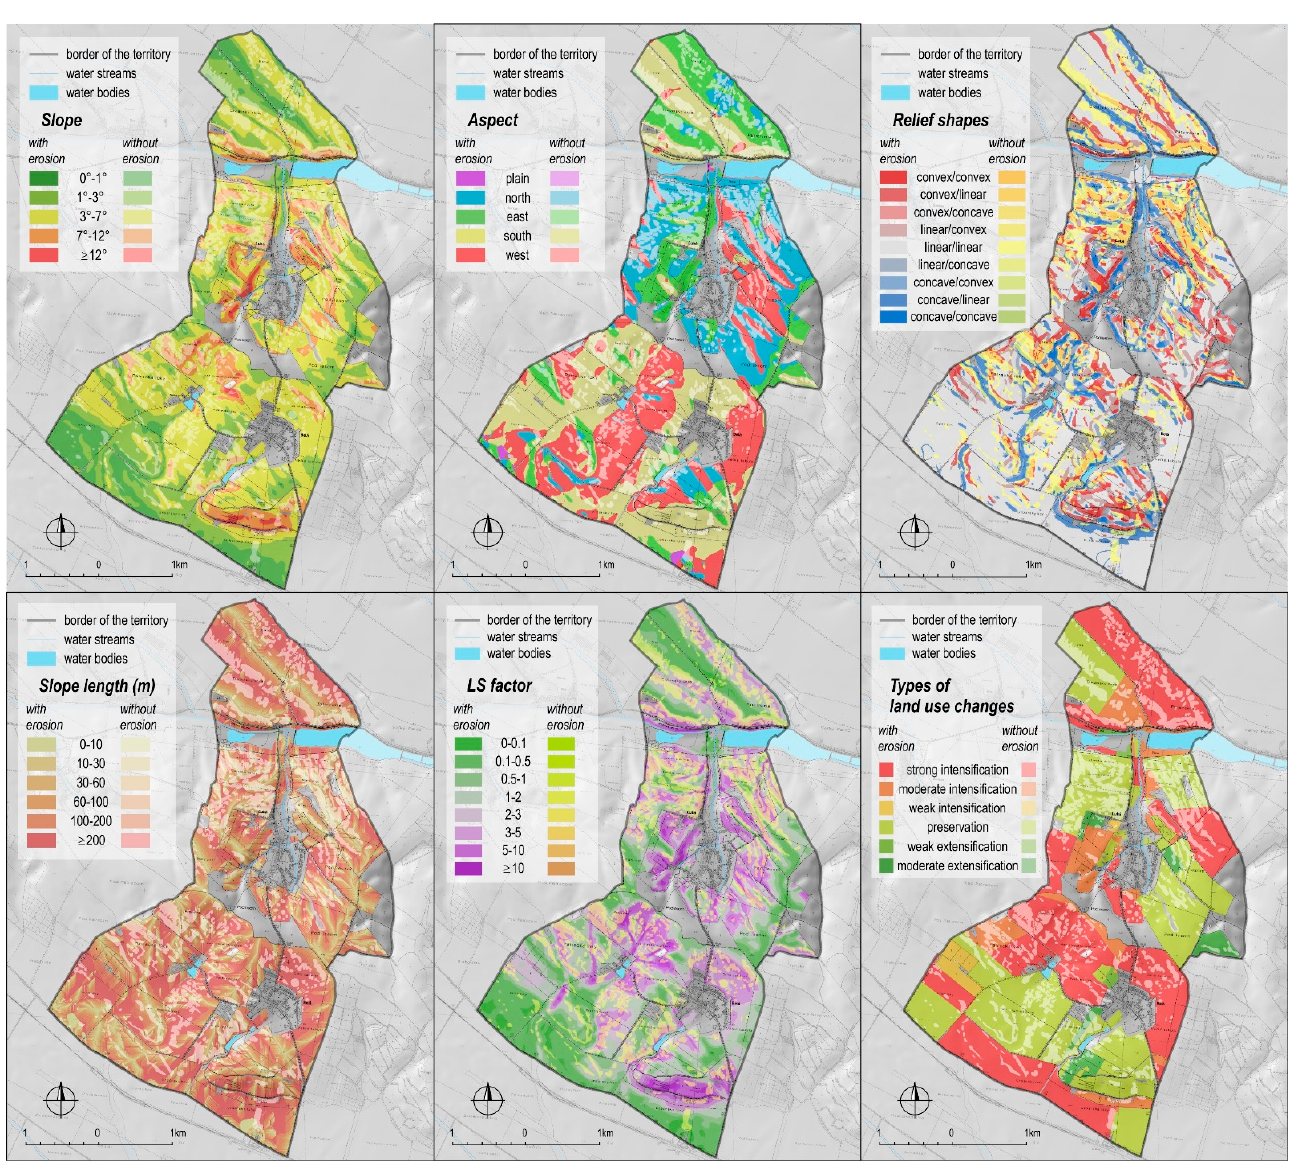
Figure 3. The combination of the spatial distribution of erosion areas and environmental factors. The individual figures show the categories of environmental factors with erosion (left column of the legend) and without erosion (right column of the legend).